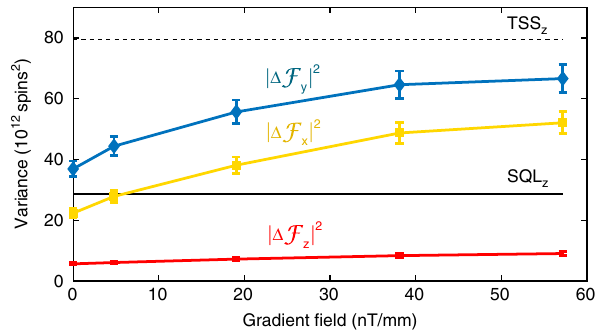
Fig. 10 Reduction of squeezing with increasing magnetic fi eld. Spin variance components increase with gradient fi eld strength. Red dots, yellow D E (cid:5) (cid:6) (cid:5) (cid:6) squares, blue diamonds represent Δ F 2 , , Δ F 2 , and Δ F 2 z x y respectively. Error bars show ±4 σ uncertainty in the variance, originating in the uncertainty of the atomic number. The dashed line and solid line show thermal spin state (TSS) (7.99(18)×10 13 spins 2 ) and standard quantum limit (SQL) (2.88(7)× 10 13 spins 2 ) noise levels, respectively for one